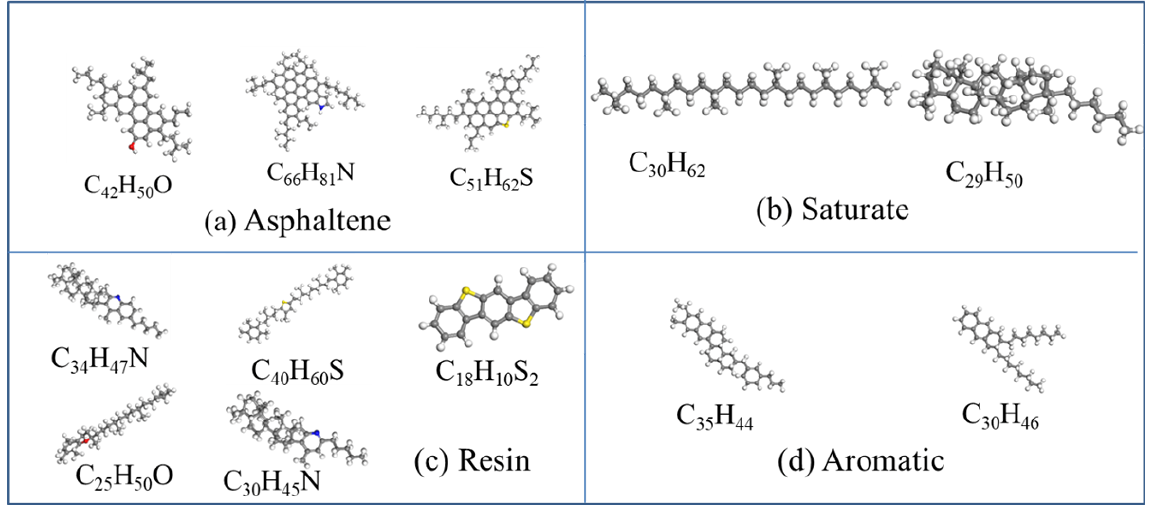
Figure 1. ( a ) Asphaltene molecular models; ( b ) Saturate molecular models; ( c ) Resin molecular mod- els; ( d ) Aromatic molecular models.